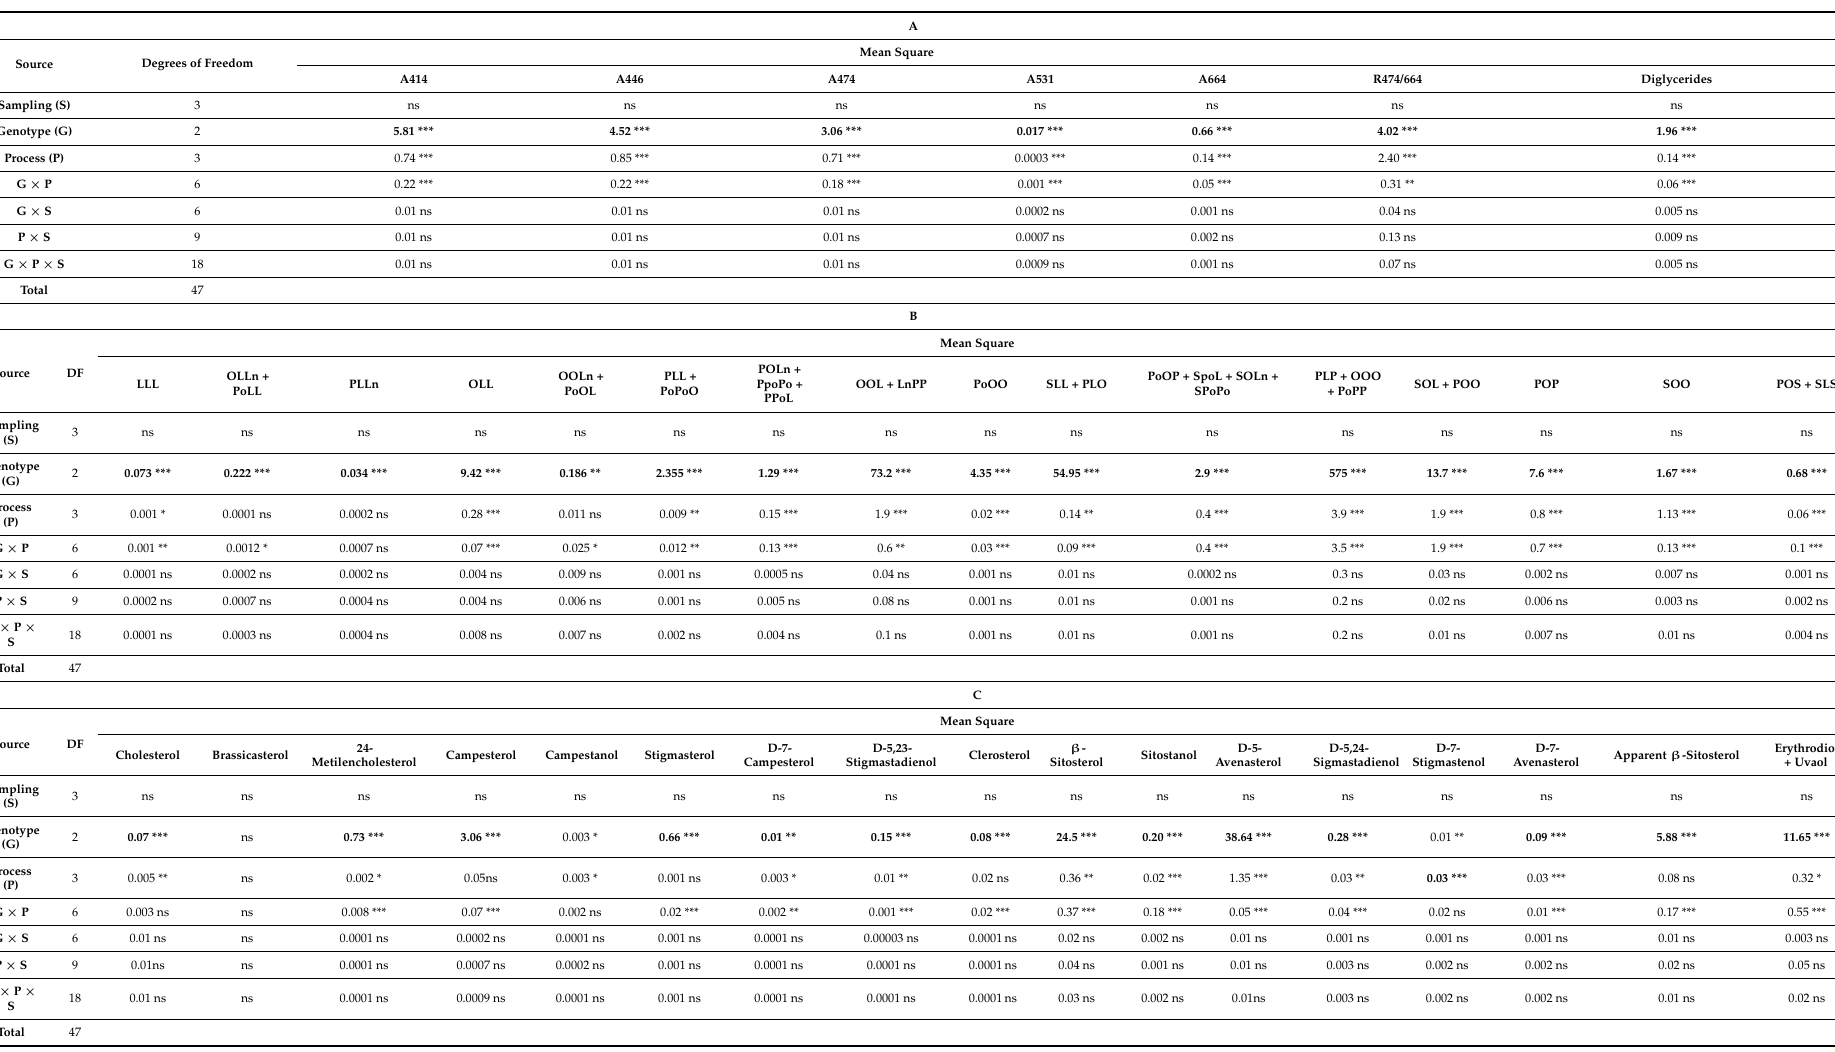
Table 1. Analysis of variance (ANOVA) for the parameters of visible and diglycerides ( A ), triglycerides ( B ), sterols ( C ), aliphatic and triterpene alcohols ( D ), and sensory attributes ( E ) of Peranzana, Canino, and Coratina EVOOs, extracted through different processes (i.e., control test, ultrasound test, destoned test, destoned-ultrasound